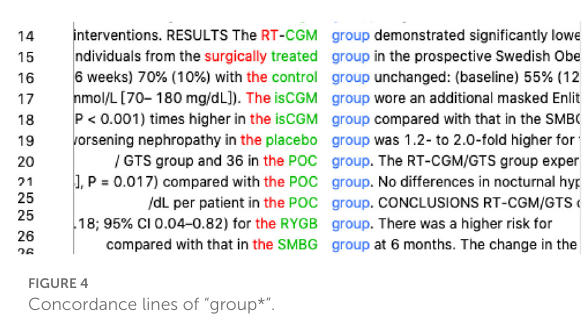
FIGURE4 Concordance lines of “group*”.